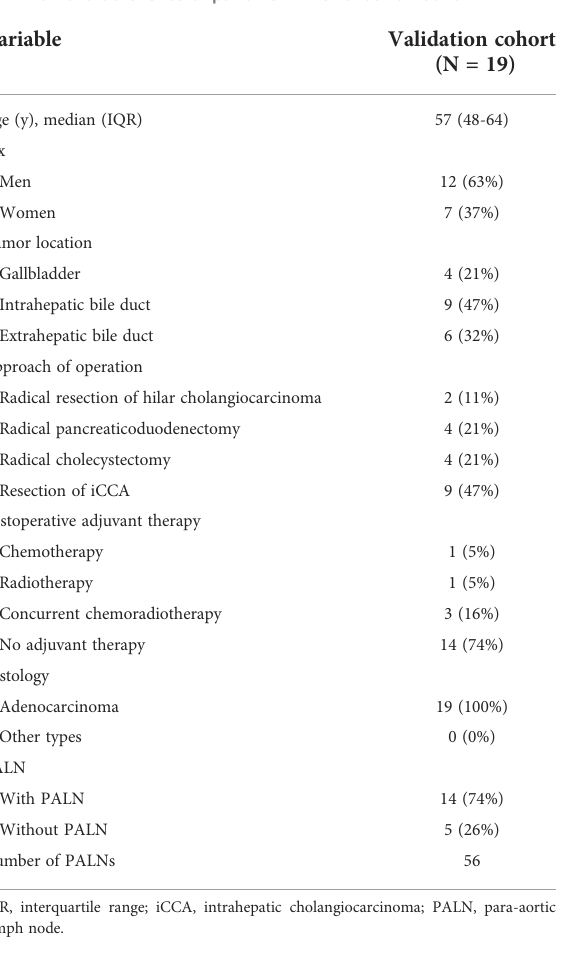
TABLE 3 Characteristics of patients in the validation cohort.